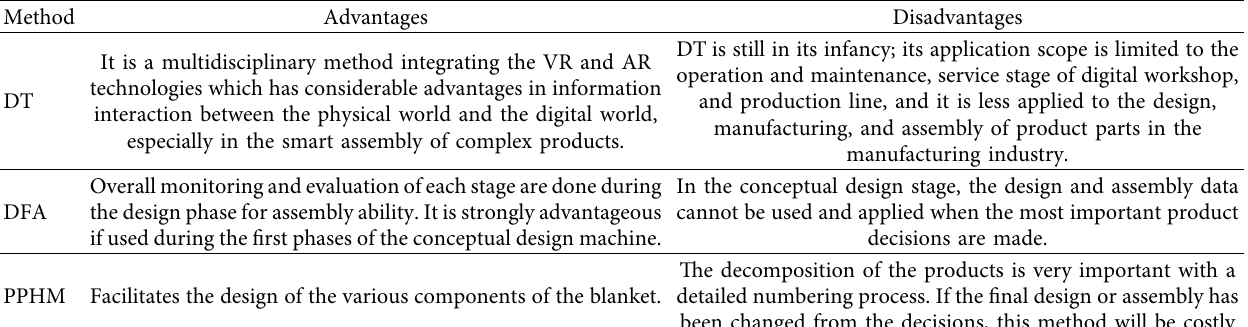
Table 1: Advantage and disadvantage analysis of the assembly methods.